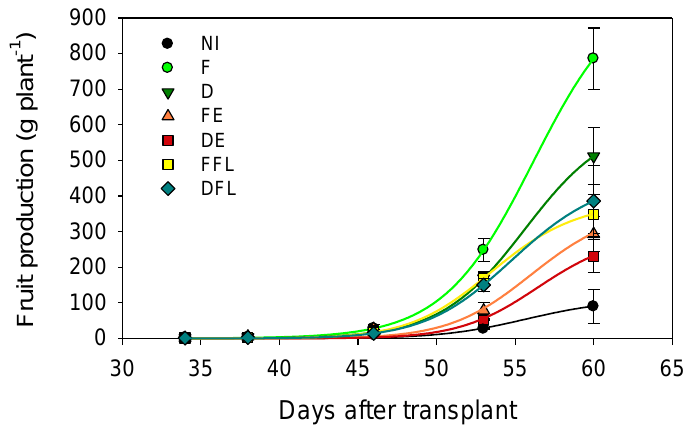
Figure 8. Course of fruit production per plant (g fresh weight-FW) during the growth period in processing tomatoes cv. Hypeel F1 under different irrigation treatments. Black vertical bars represent the standard error.